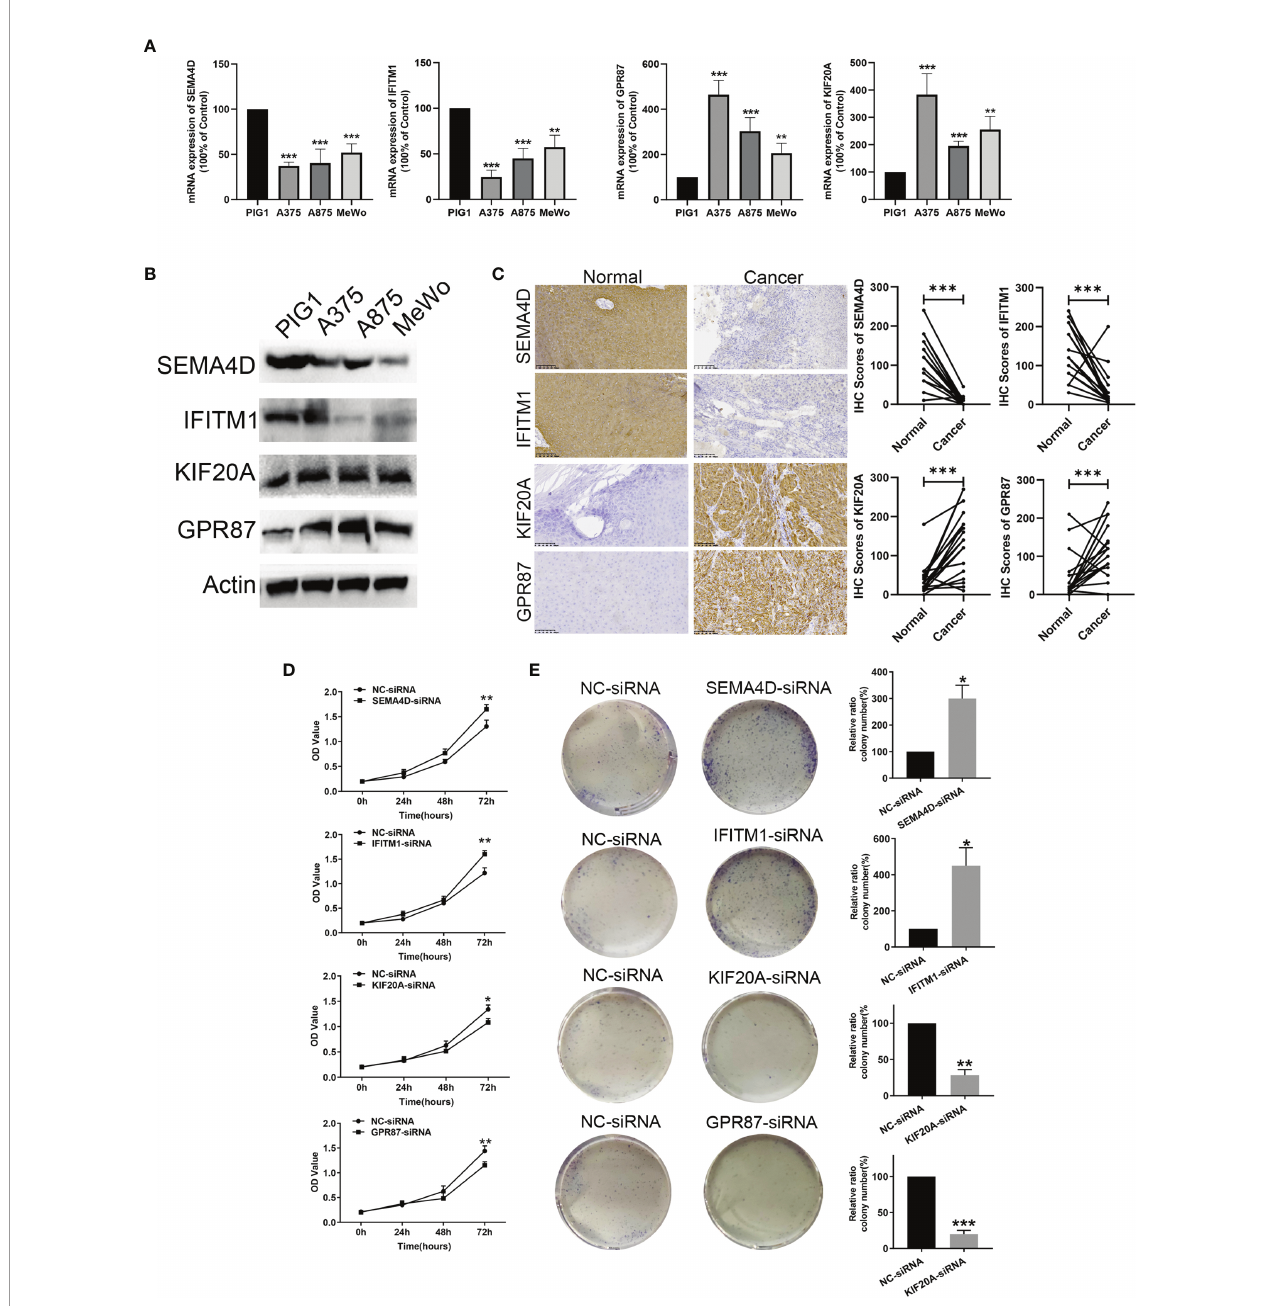
FIGURE 9 | Protein level validation andfunctional analysis of SEMA4D, IFITM1, KIF20A and GPR87 in melanoma versus normalsamples. (A) and (B) The mRNA and prorenin levelexpression offourgenes basedonmelanocytes andmelanoma cells (A375, A875, and MeWo). (C) IHC analysis of SEMA4D,IFITM1, KIF20A and GPR87 in normaland melanoma tissue. (D) CCK8 assay. (E) Colony formation assays. Datarepresent means± SDs; * P < 0.05, ** P < 0.01 and *** P < 0.001 ( versus control